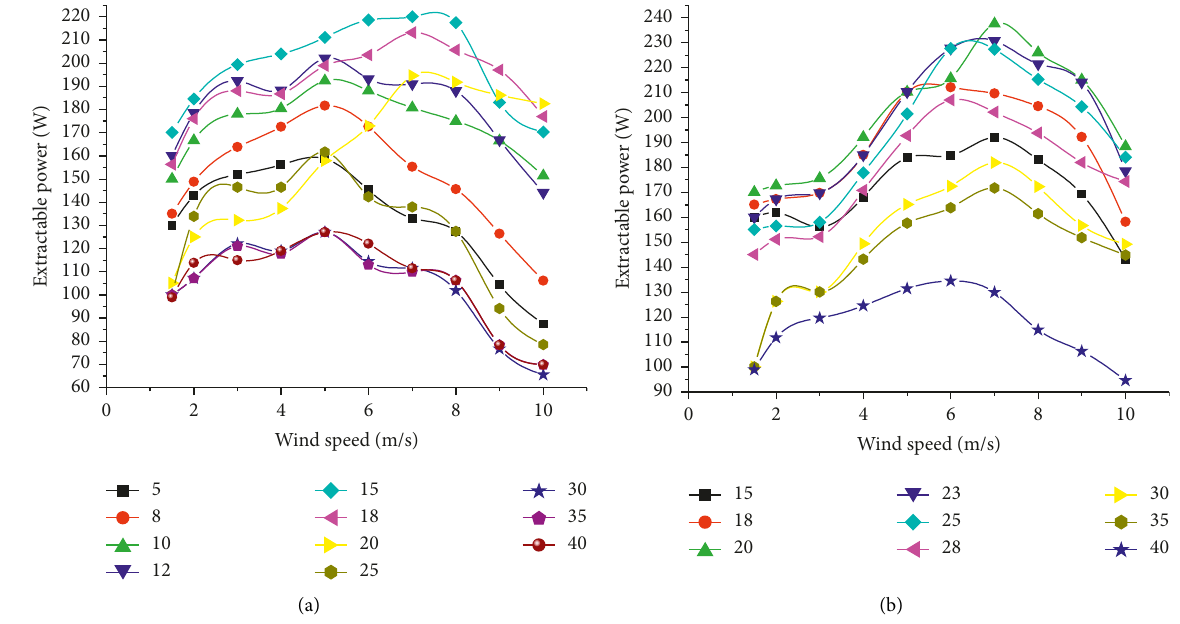
Figure 11: (a) Extractable power versus wind speeds for aluminium and (b) Styrofoam blades,